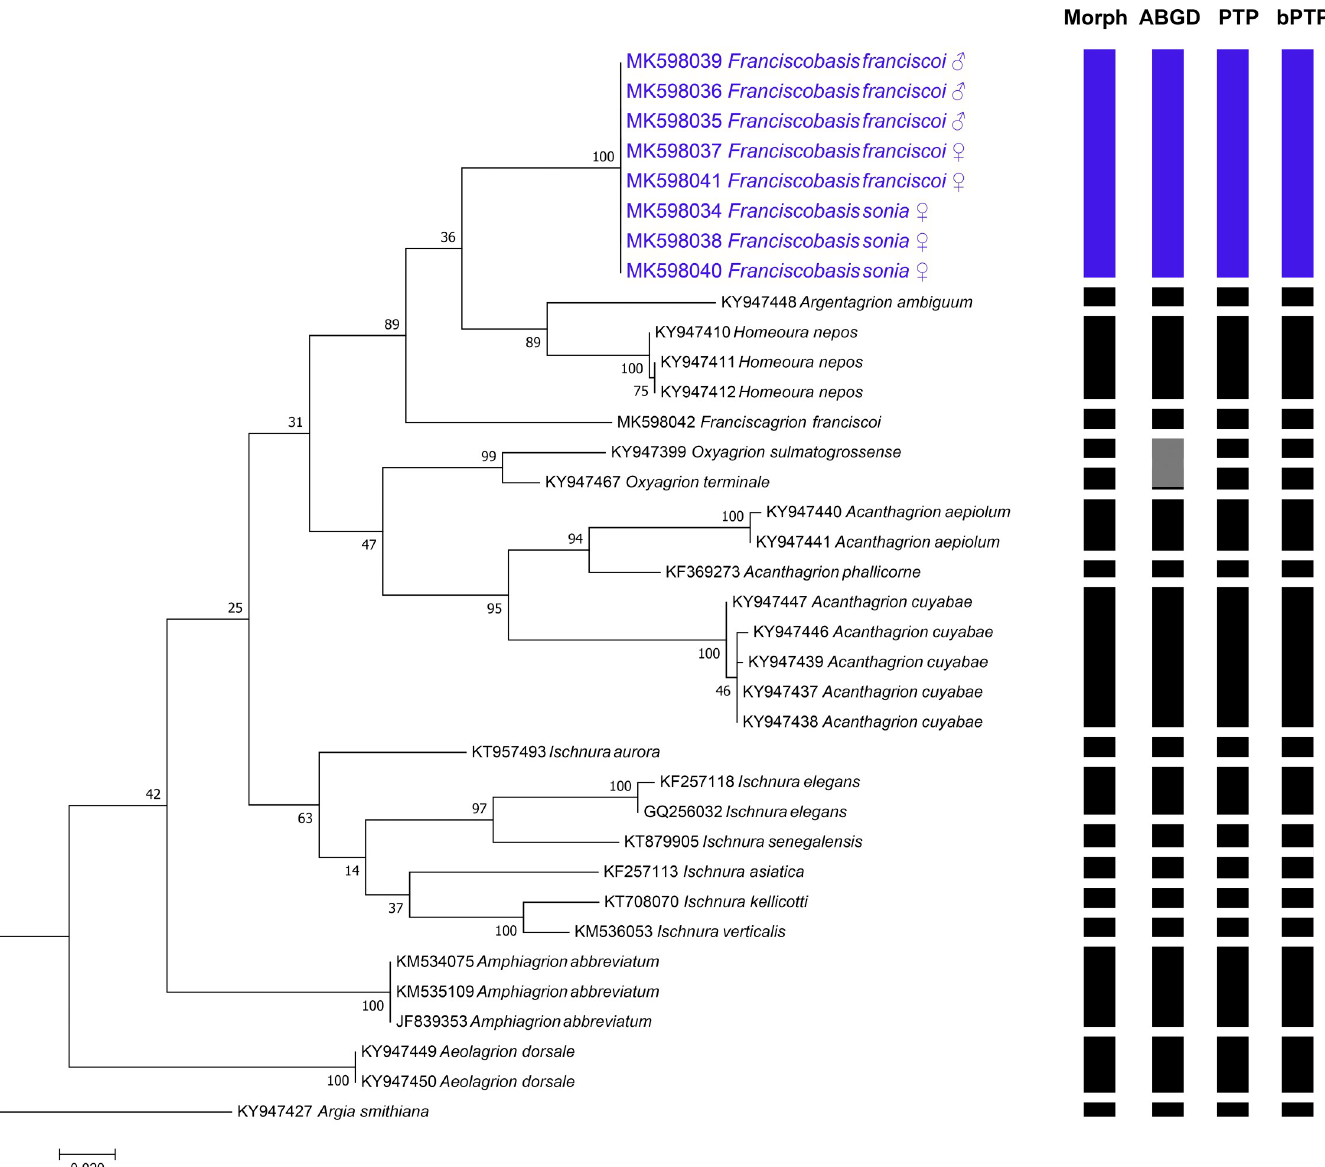
Fig 7. Maximum likelihood phylogenetic tree of Franciscobasis species based on the COI gene. Shown on the right are the results of species delimitation analyses using morphological characters (Morph), Automatic Barcode Gap Discovery (ABGD), Poisson tree processes (PTP) and Bayesian implementation of the Poisson Tree Process (bPTP),